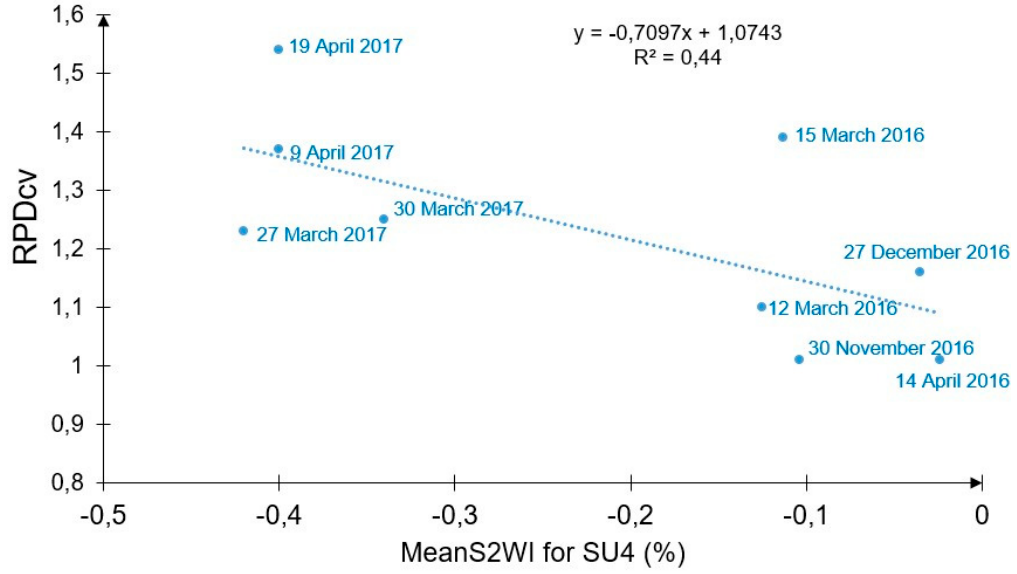
Figure 9. Plot of RPDcv against the mean S2WI for the SU4 soilscape unit equipped at the ICOS-Gri site.